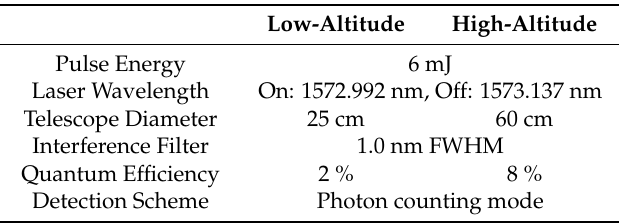
Table 1. Parameters of the 1.6 μ m DIAL system.